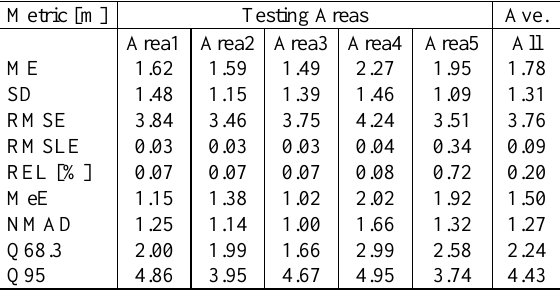
Table 1. The accuracy of the predicted